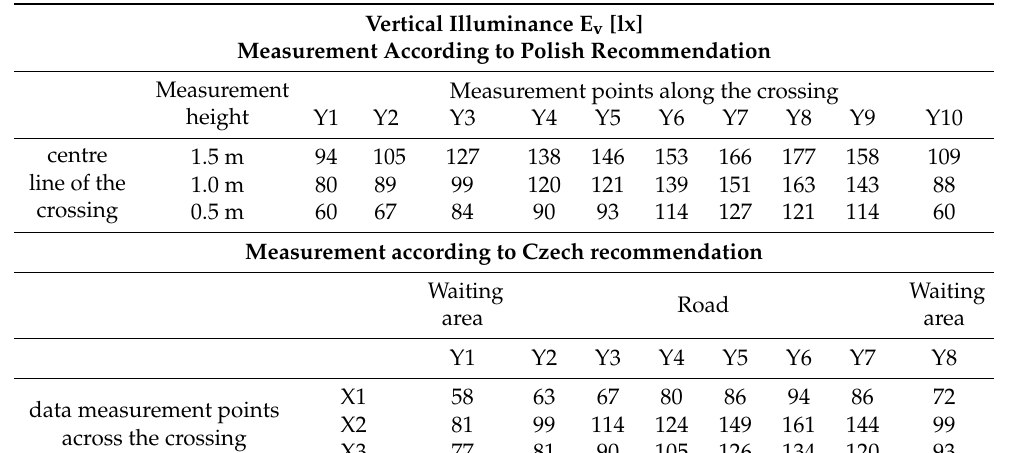
Table A3. Measurement results for the quality of illumination at pedestrian crossing no. 2—direction